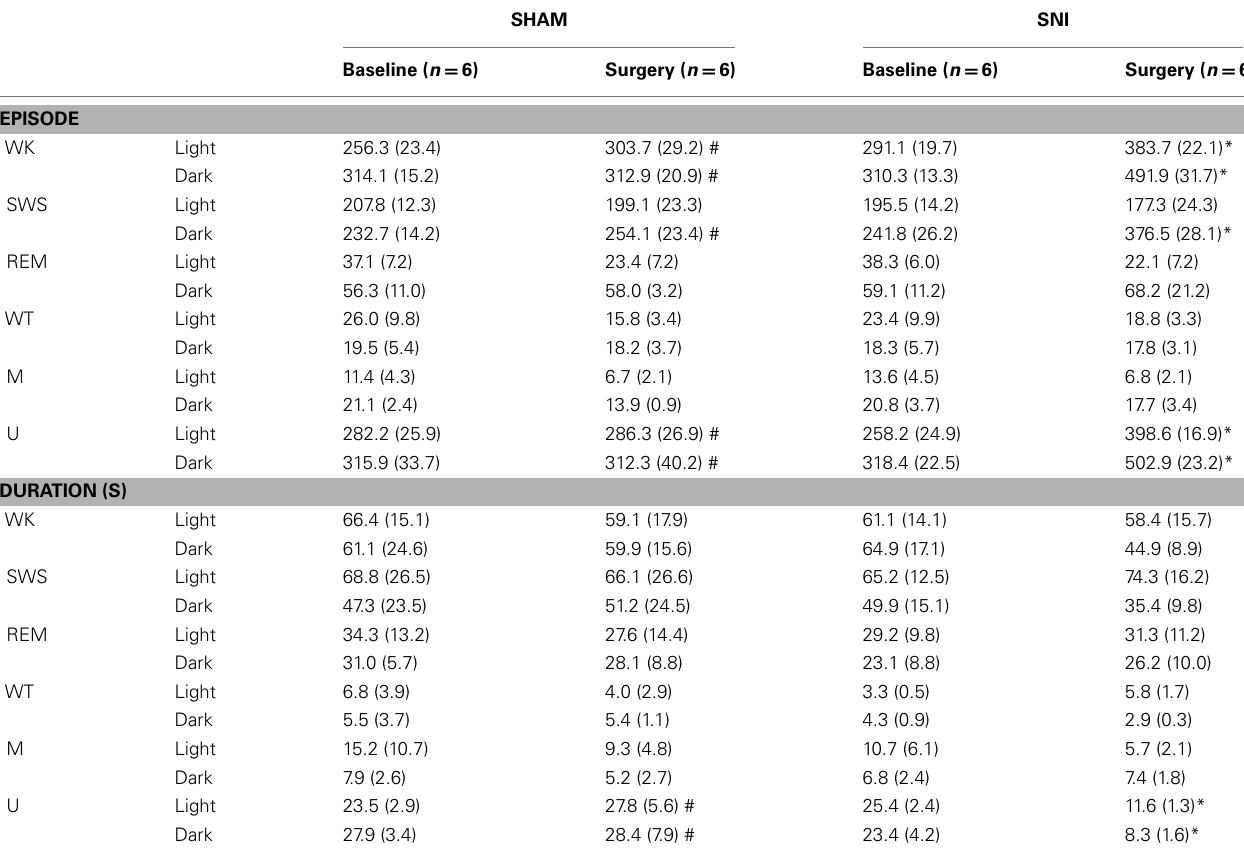
Table 1 |The number and mean duration of episodes from the different sleep states to wakefulness are shown for the light and dark phases (expressed as mean value per period of